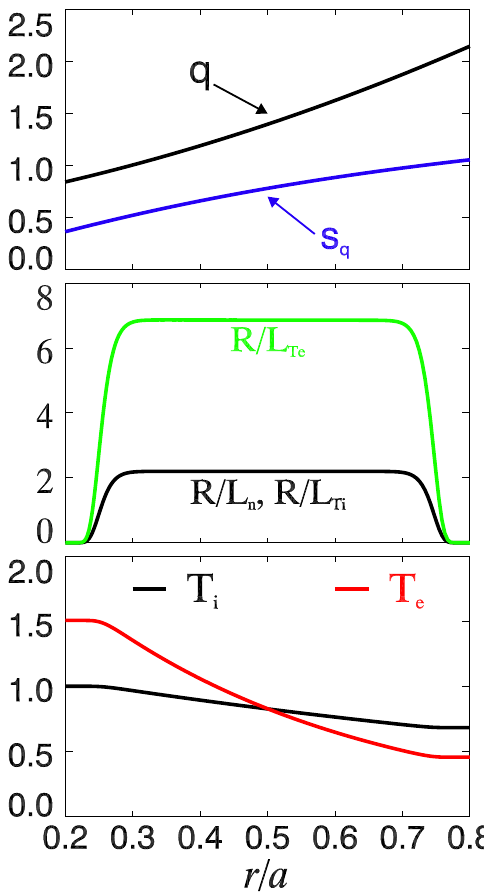
s q (top figure), normalized ˆ